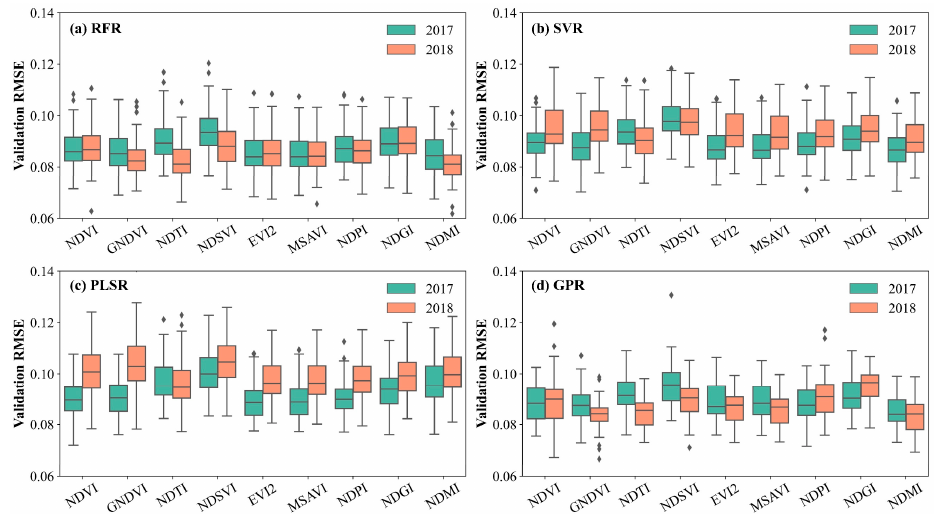
Figure 7. Validation accuracy of RFR ( a ), SVR ( b ), PLSR ( c ), and GPR ( d ) methods in the East subre- gion. Diamonds are outliers beyond the upper and lower quartiles by 1.5 times the interquartile range.